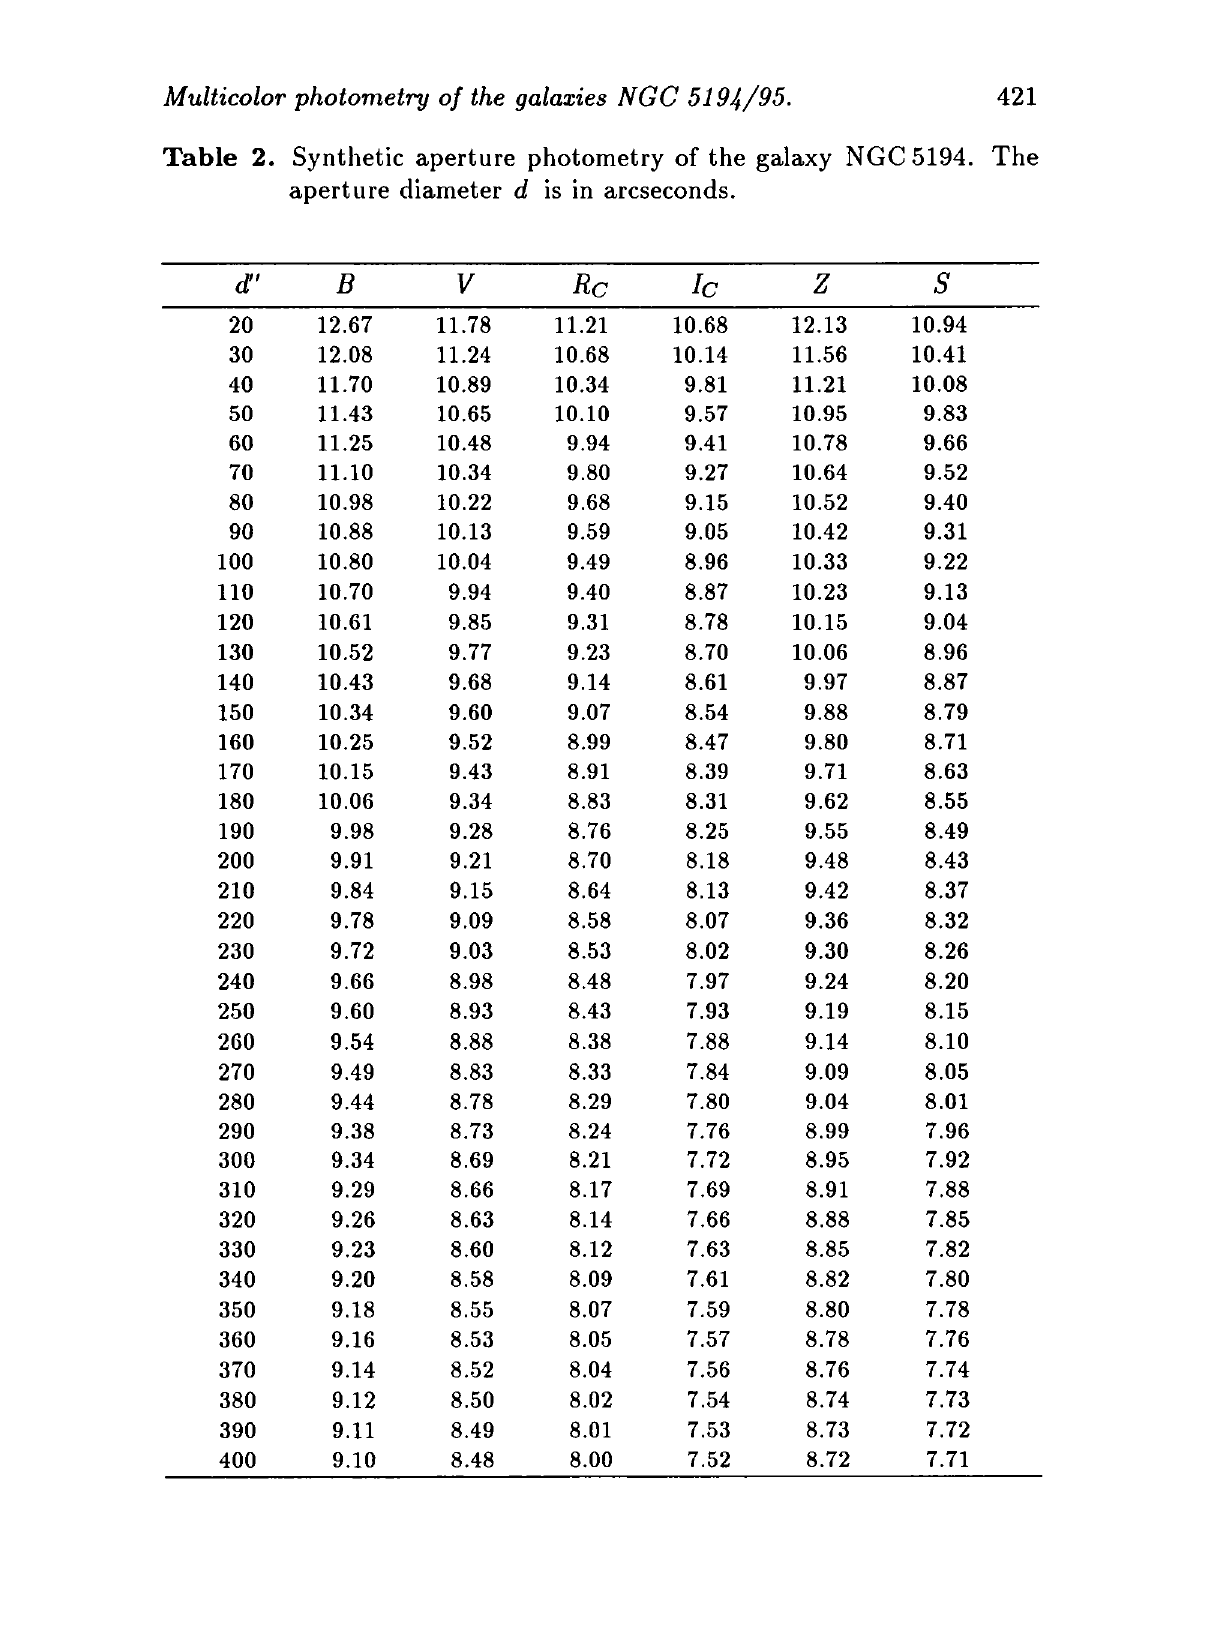
Table 2. Synthetic aperture photometry of the galaxy NGC 5194. The aperture diameter d is in